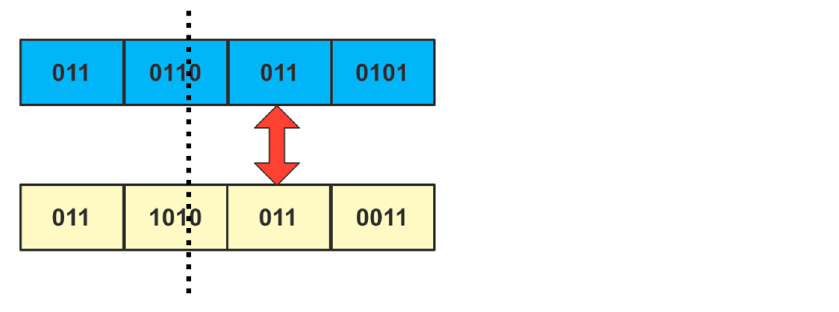
Figure 9. Property fields for the two alarm records waiting for a crossover operation.